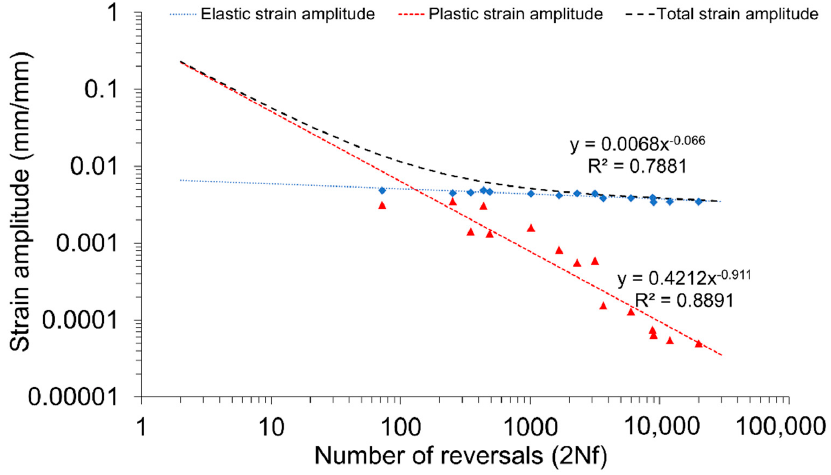
Figure 15. Number of half-cycle reversals vs. strain amplitude in log-log coordinates.